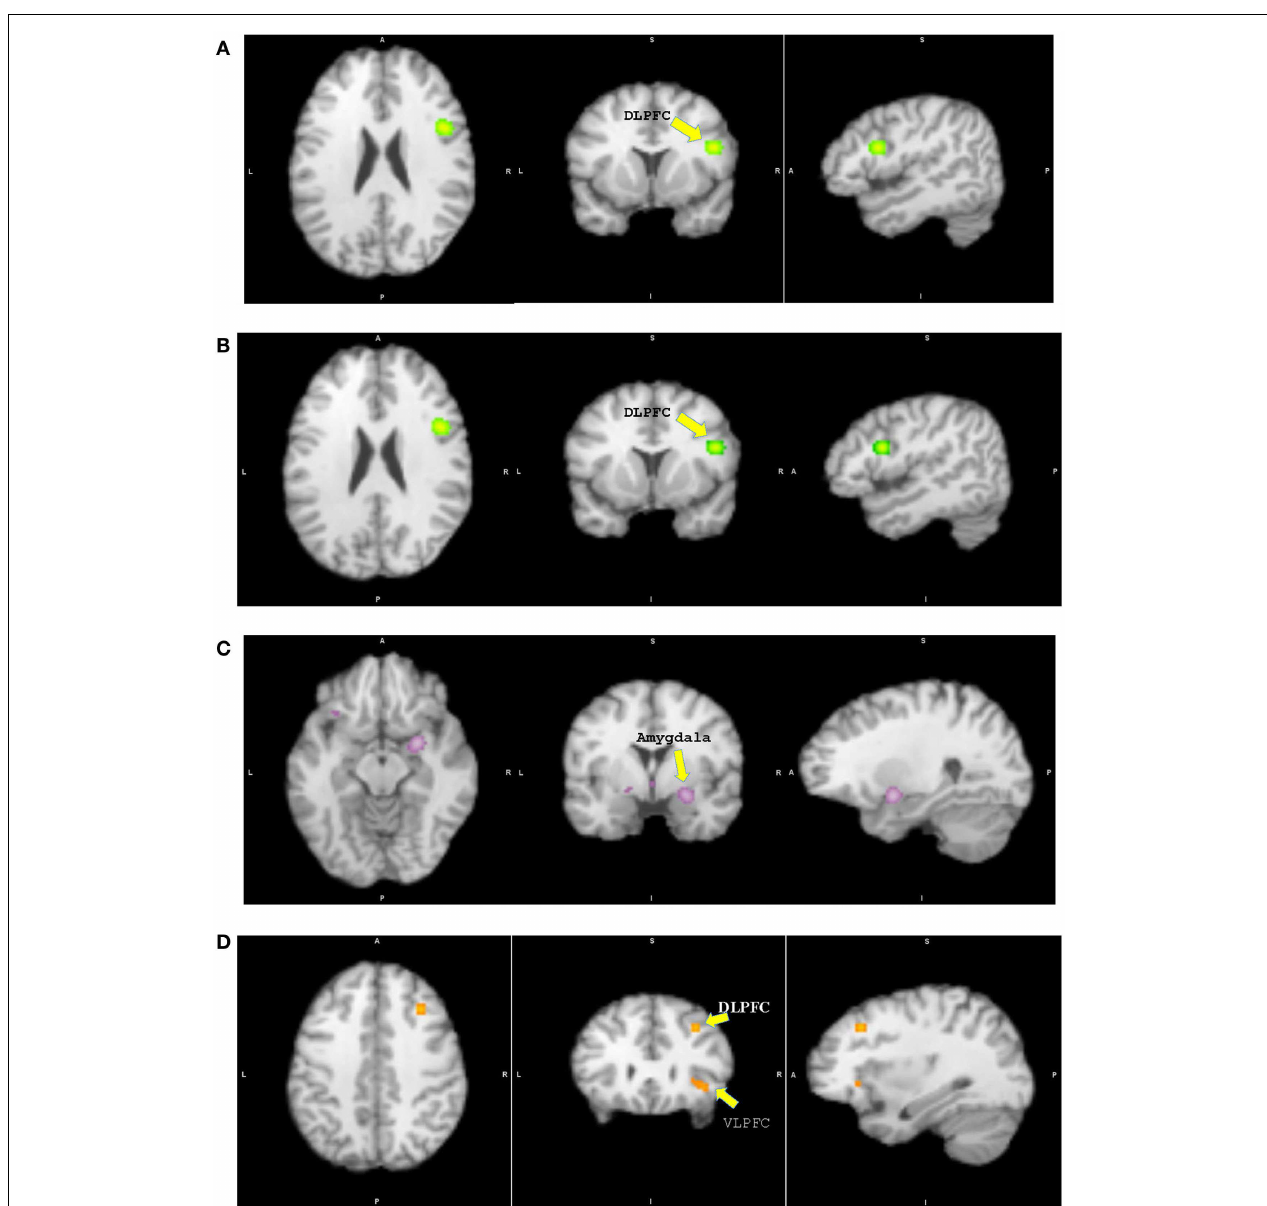
size = 1048mm 3 , extreme value = 0.020; (B) DLPFC: x = 46, y = 8, z = 22, cluster size = 1056mm 3 , extreme value = 0.020; (C) Amygdala: x = 26, y =− 2, z =− 12, cluster size = 1120mm 3 , extreme value = 0.022; (D) DLPFC: x = 32, y = 24, z = 38, cluster size = 224mm 3 , extreme value = 0.013;VLPFC: ventrolateral prefrontal